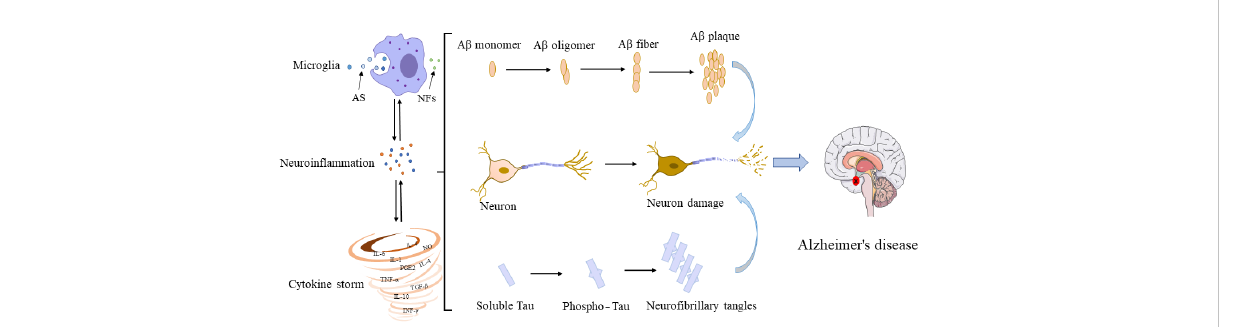
FIGURE 2 Interconnections among microglia, A b , tau, and neurons. In their early developmental stages, microglia enhance the phagocytic capacity and generate phagocytoma abnormal material, such as cell debris and misfolded proteins. Subsequently, M2 microglial cells are promoted to release proin fl ammatory mediators, leading to an in fl ammatory storm. In this process, the amyloid monomers gradually accumulated to form amyloid plaques. Meanwhile, free tau proteins are phosphorylated and aggregated in neurons to form neuro fi brillary tangles. The accumulation of A b plaques and the formation of neuro fi brillary tangles could positively feedback to microglia to promote the activation of microglia, leading to impaired ability to phagosome foreign objects. AS, abnormal substances (i.e., cell debris and misfolded protein); NFs, neurotrophic